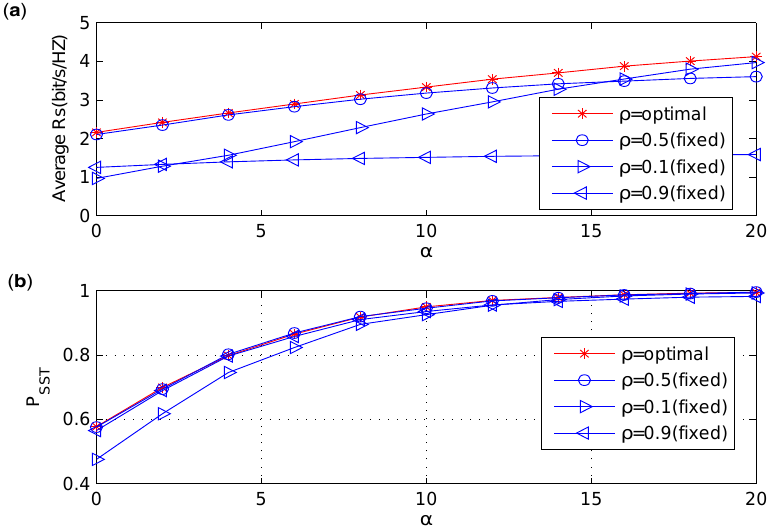
Figure 7. ( a ) Average Rs versus α for various ρ . ( b ) P SST versus α for various ρ